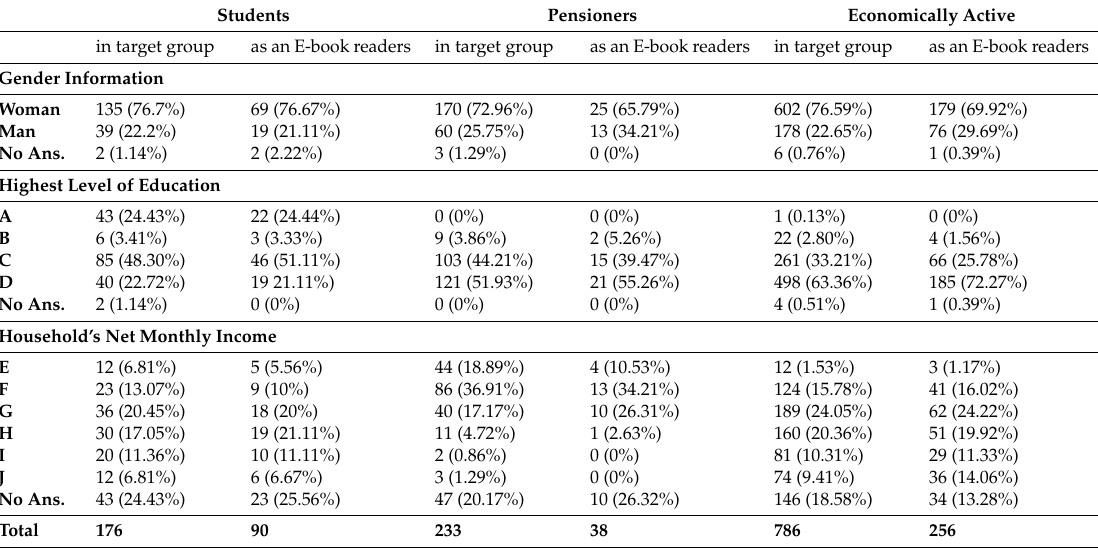
Table 2. Socio-economic information about focus